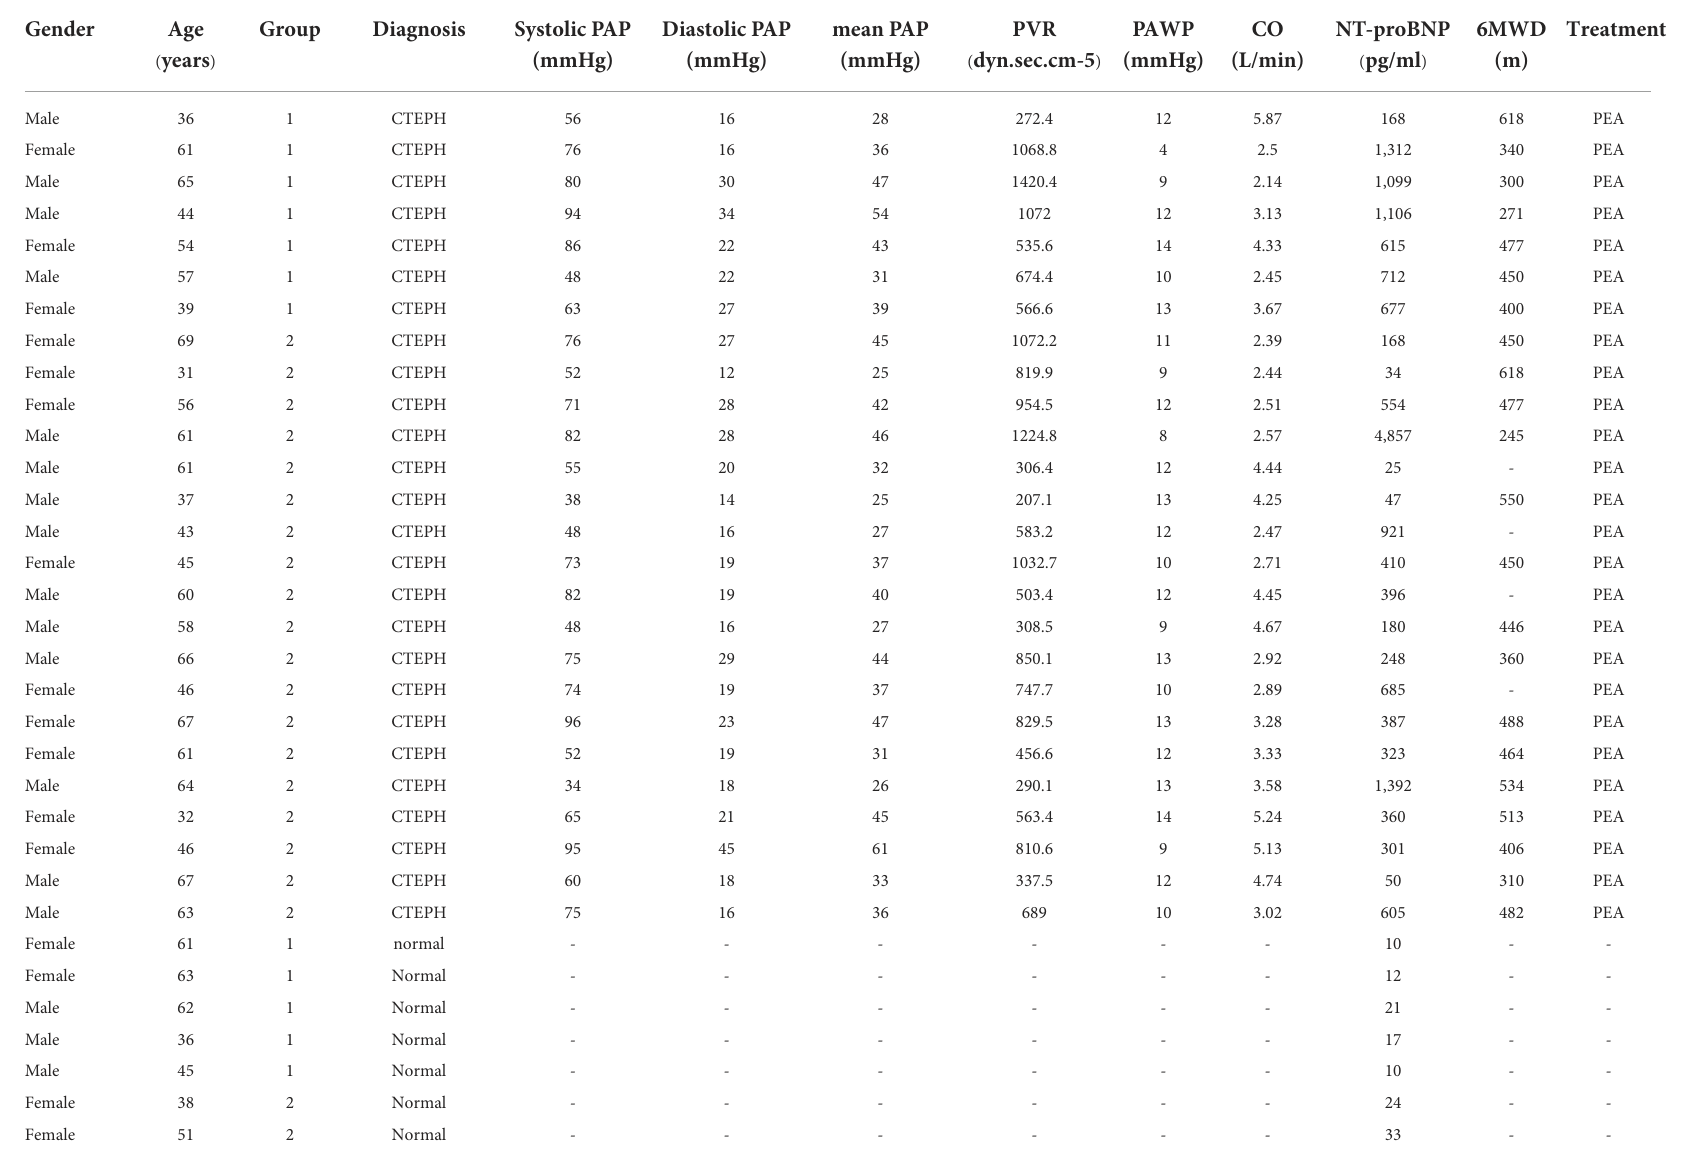
TABLE 1 Clinical information of patients with CTEPH and healthy